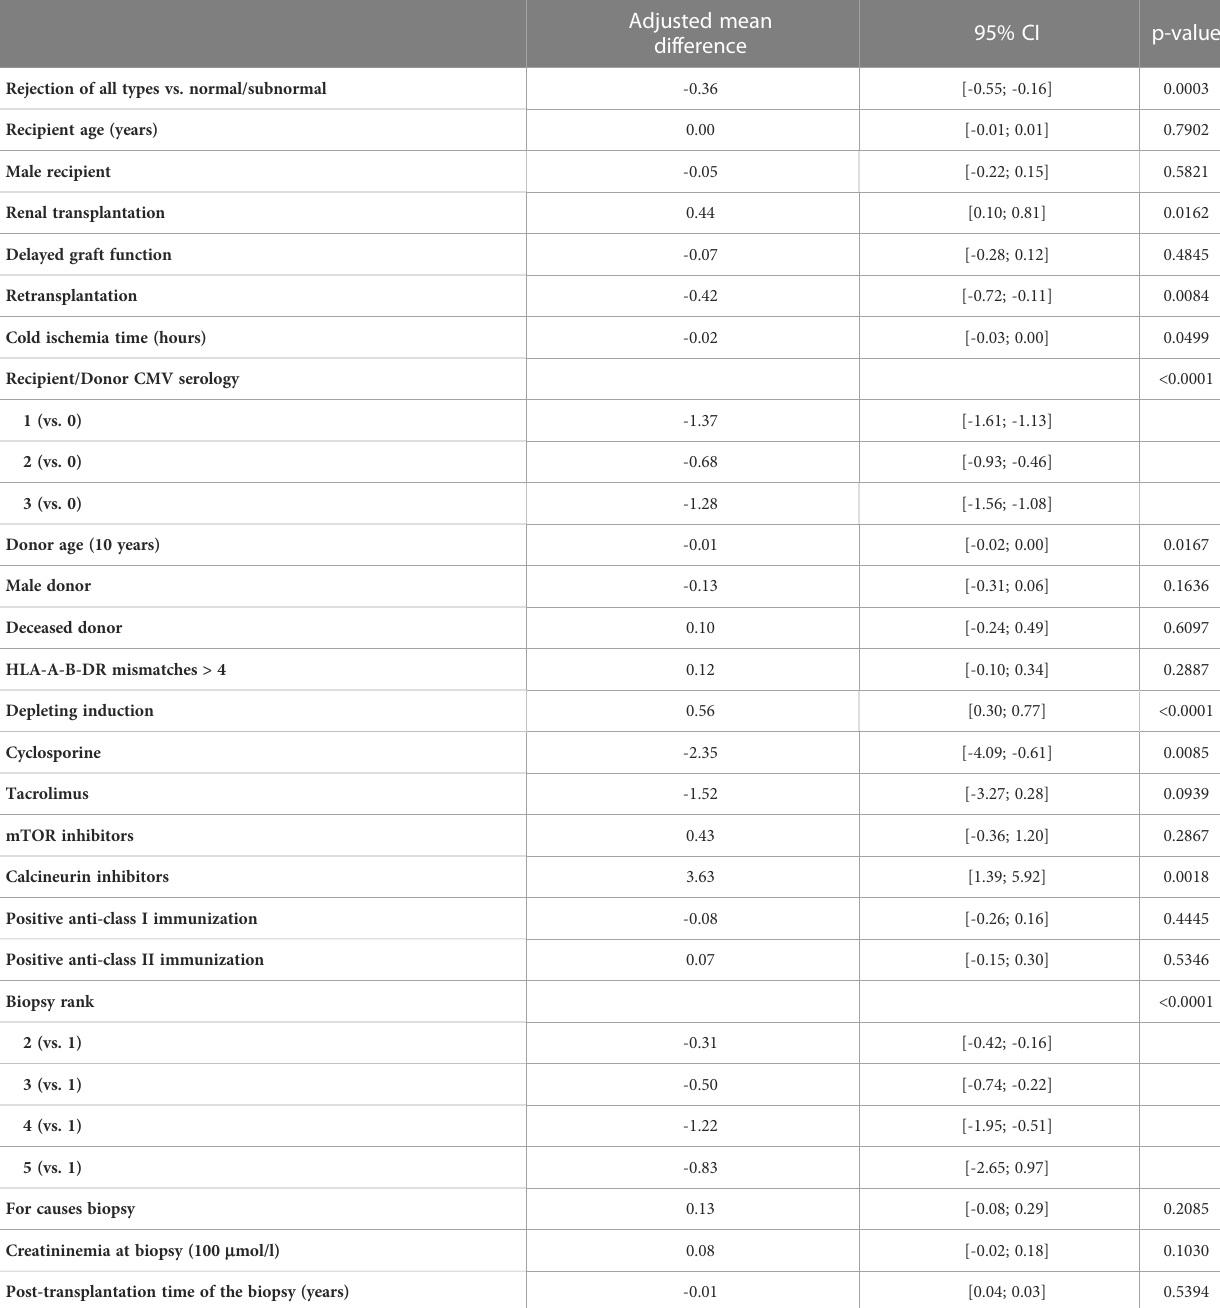
TABLE 5 Results of the multivariable linear mixed model of log of the ratio between B lymphocytes in absolute number and CD28-CD8+ T cells in absolute number measured at the time of biopsy (Rejection of all types versus